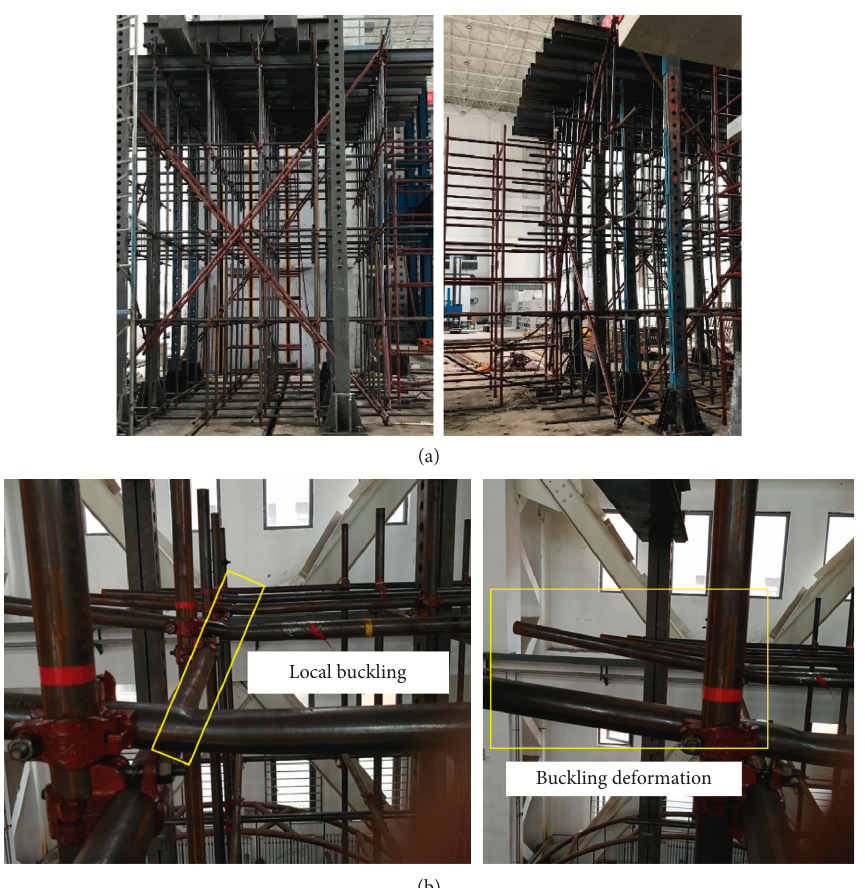
Figure 16: Failure situations of Model 3. (a) Overall buckling deformation of the scaffold. (b) Deformation of horizontal rods in the loading